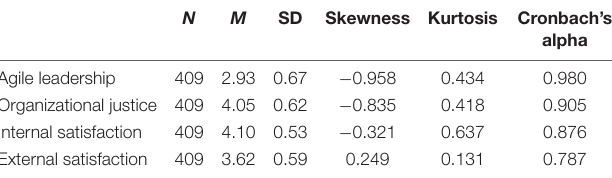
TABLE 1 | The skewness, kurtosis, and reliability values of the scales.